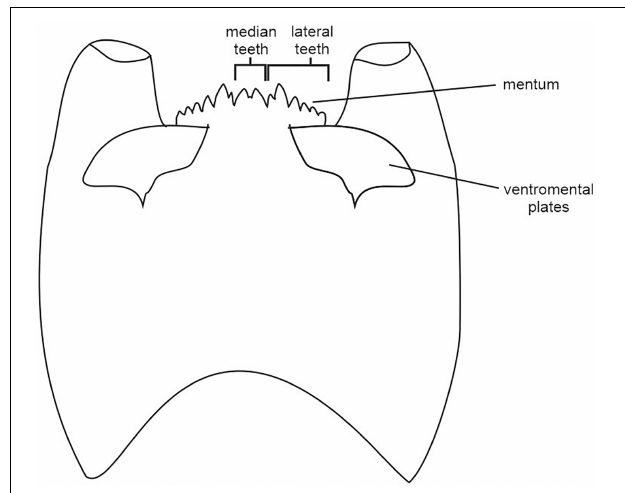
FIGURE 2 | Chironomidae head capsule with mouthpart